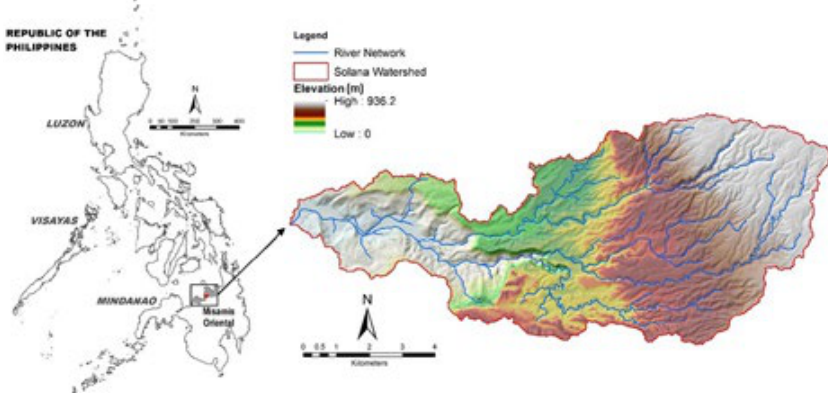
Fig. 1: Geographic location of Solana Watershed in north-central Misamis Oriental, Philippines